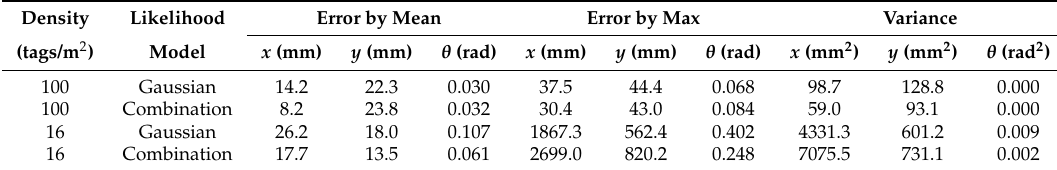
Table 5. Self-localization errors with 96 HF-band RFID reader systems.